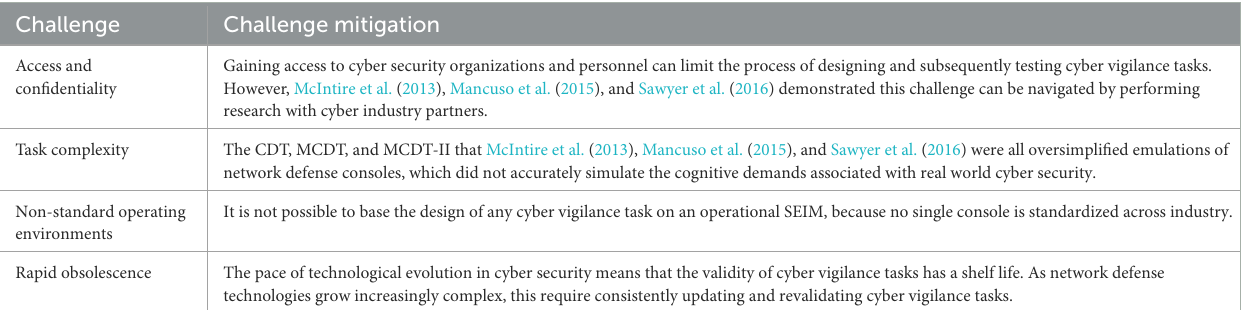
TABLE 3 Cyber vigilance task creation